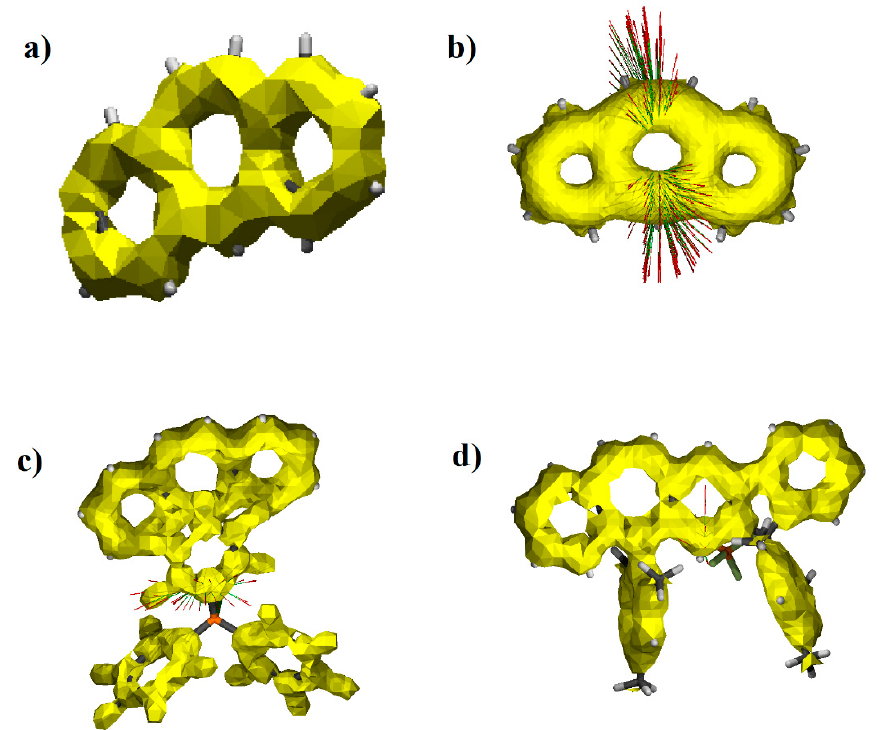
Figure 10. ACID surfaces for selected 5 H ‐ dibenzo[a,d][7]annulene derivatives with different aroma ‐ ticity of the central ring: XOHXIC [73] (0.9363) ( a ), XOHXOI [73] (0.9201) ( b ), XOHXEY [73] (0.9169) ( c ), RULROI [74] (0.8818) ( d ). In parentheses are given the HOMED values for the middle ring.